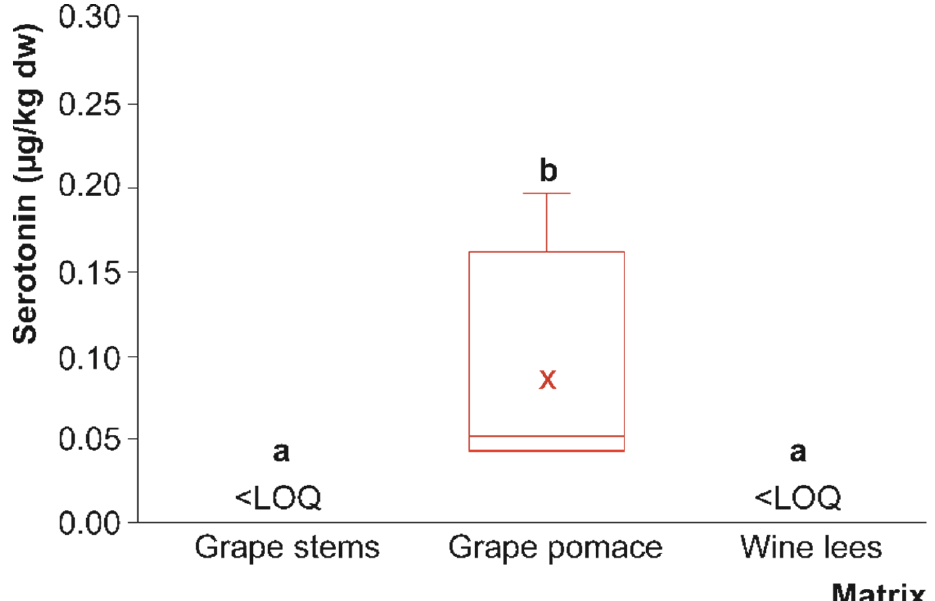
Figure 3. Box plots with quartiles (upper values of 75%, median values of 50%, and lower values of 25%) of serotonin present in grape stems, grape pomace (red box), and wine lees (µg/kg dry weight (dw)) ( n = 4 for each by-product). Boxes with a different letter within each plot were statistically different at the significant level of p < 0.05 according to the analysis of variance (ANOVA) and Tukey’s multiple range test. LOQ, limit of quantification (500 pmol/L).